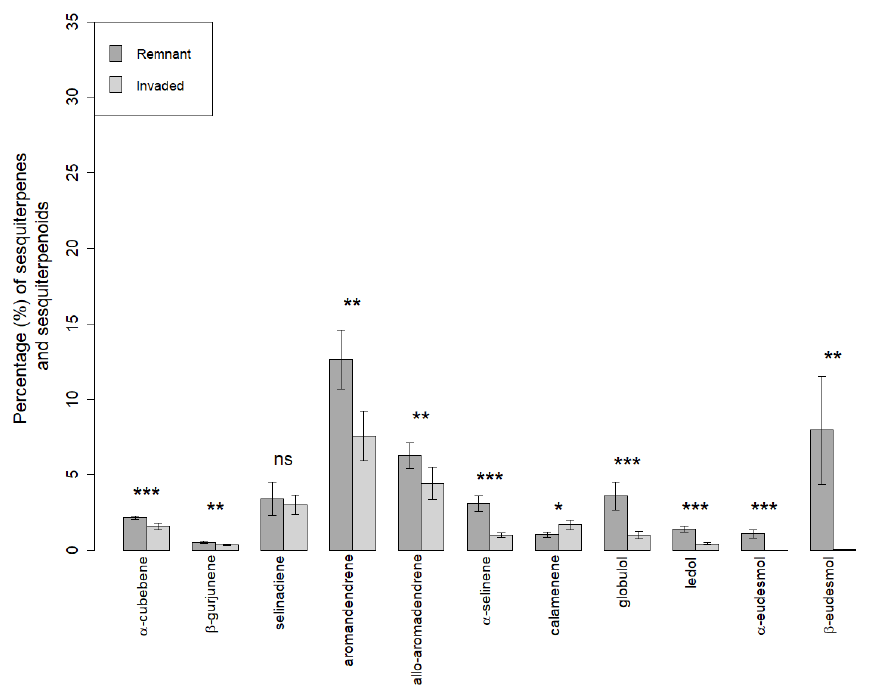
Figure 7. Histogram representing the amount (%) of sesquiterpenes and sesquiterpenoids annotated as volatiles collected in remnant area of natural vegetation (R) and areas invaded by P. undulatum (I). Each value is the mean of five measurements ± SD. Error bars indicate standard deviation, and the asterisks indicate significant differences between R and I: ns > 0.05, * 0.01 < p < 0.05, ** 0.001 < p < 0.01, *** p <